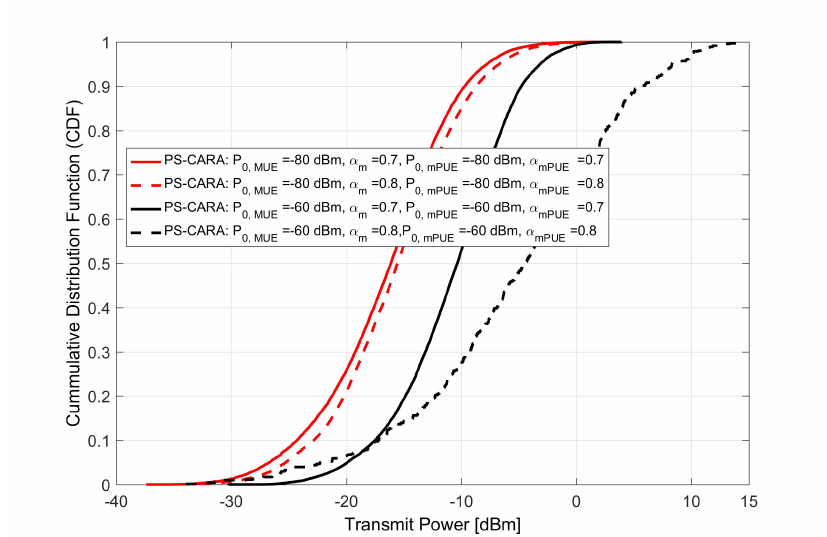
Figure 6. User transmit power under the proposed PS-CARA scheme for various ( P 0 ) and ( α ).